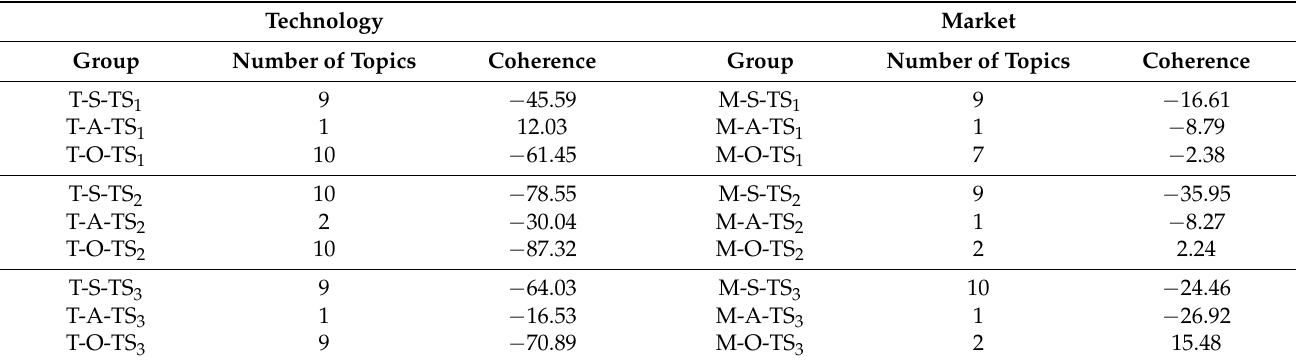
Table 5. Topic coherence value for each